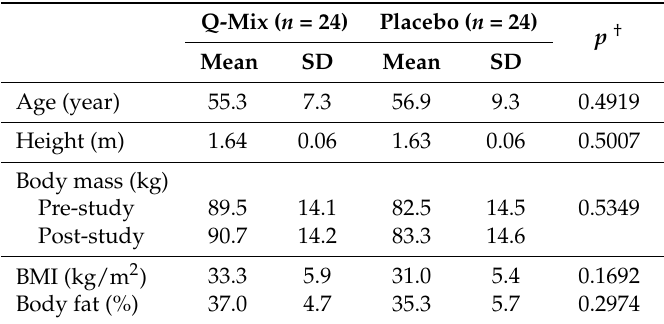
Table 1. Participants’ characteristics by supplement groups *.